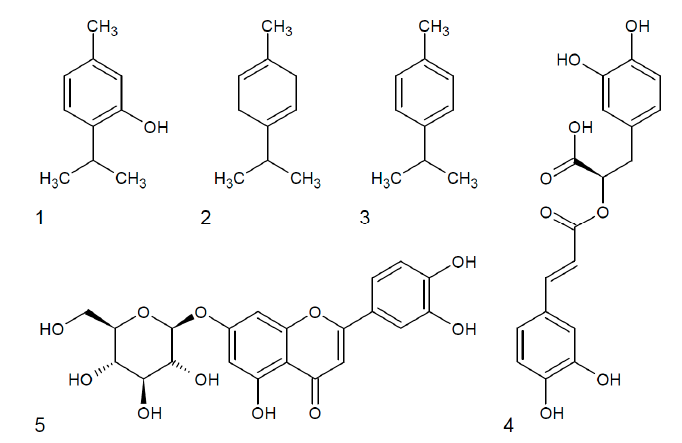
Figure 3. Chemical structures of compounds dominating in essential oil ( 1 – 3 ) and phenolic fraction ( 4 , 5 ): 1 : thymol, 2 : γ -terpinen, 3 : p -cymen, 4 : rosmarinic acid, 5 : luteolin 7-O -glucoside.